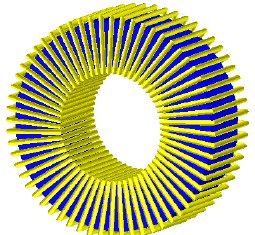
Figure 4. Geometry of the 60-turn inductor used for the 3D simulations with the TN23/14/7 ferrite core with right angled